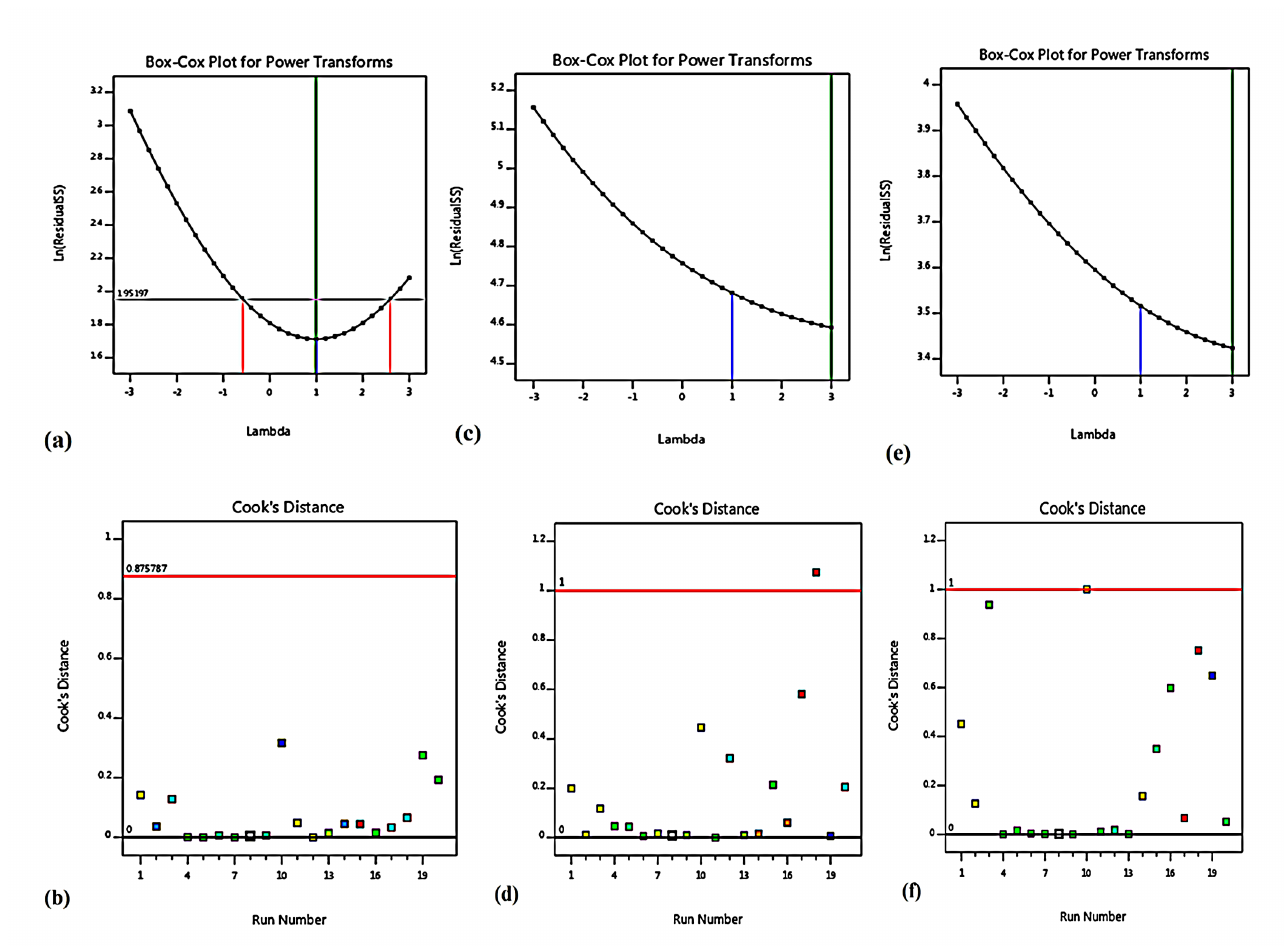
FIGURE 4 - (a) Box-cox plot for “response-1” with influence by factors considered in model study, (b) Cook´s distance chart for “response-1” with influence by factors considered in model study, (c) Box-cox plot for “response-2” with influence by factors considered in model study, (d) Cook´s distance chart for “response-2” with influence by factors considered in model study, (e) Box-cox plot for “response-3” with influence by factors considered in model study, (f) Cook´s distance chart for “response-3” with influence by factors considered in model